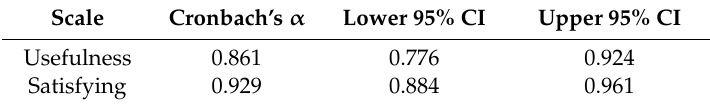
Table 1. Scale reliability analysis for acceptance scales usefulness and satisfying. Scale